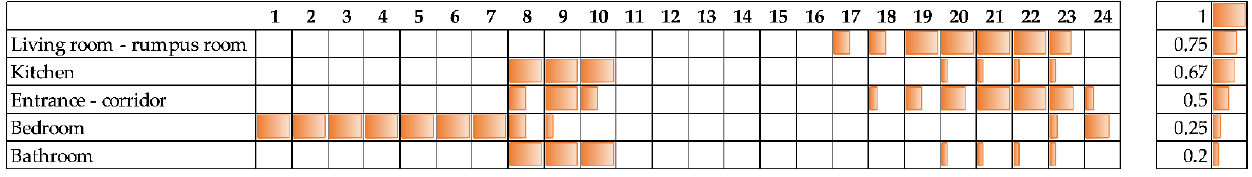
Figure 3. Daily schedule of occupancy and percentages relative to the maximum value. Table 1. Properties of the wall layers. Table 1. Properties of the wall